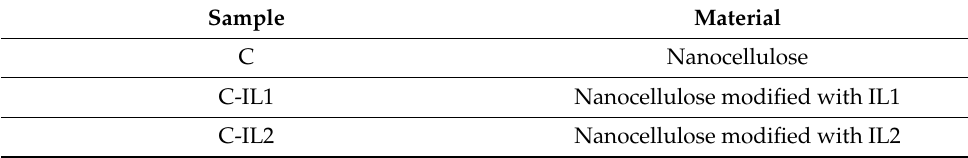
Table 4. A list of obtained nanofillers.